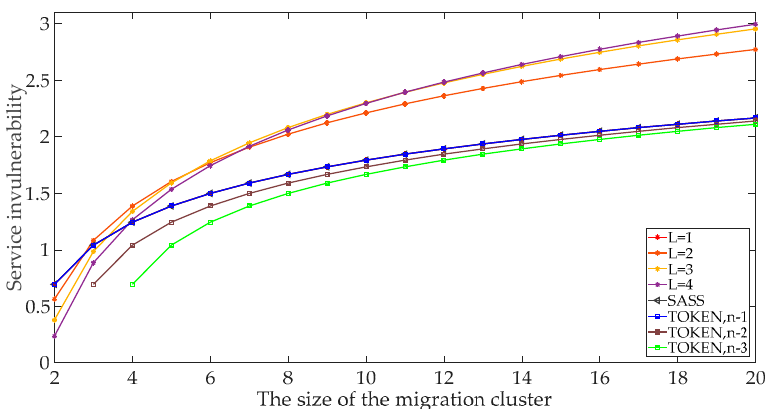
Figure 11. Comparison of services invulnerability.